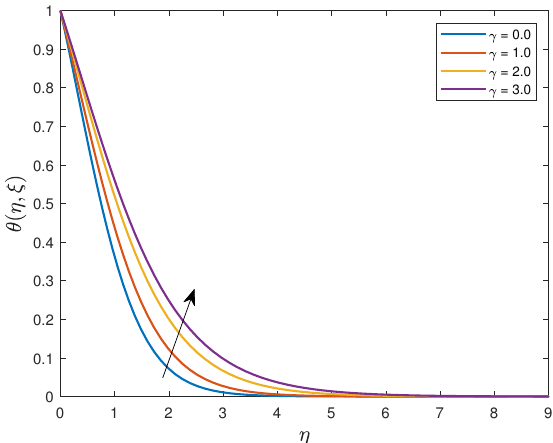
Figure 20. The influence of γ on fluid temperature.